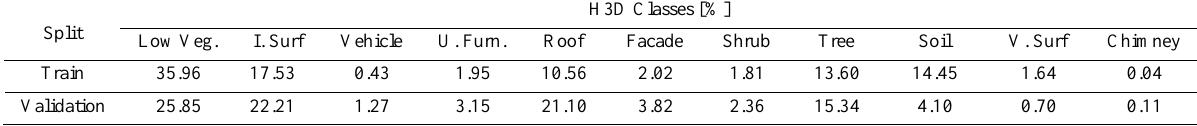
Table 1. Comparison of class occurrences in H3D